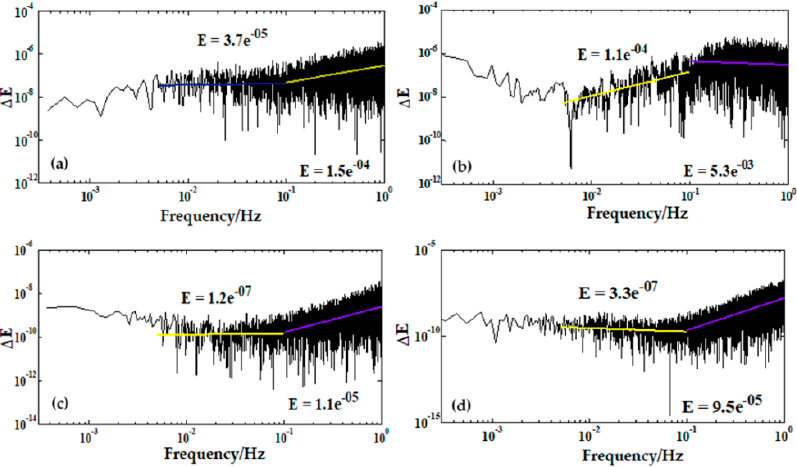
Figure 8. Energy (E) from AA6061 ‐ T6 surface after immersion in seawater under laminar flow ( a ) at 5 days and ( b ) after 30 days of exposure and stationary flow ( c ) at 5 days and ( d ) after 30 days of exposure.